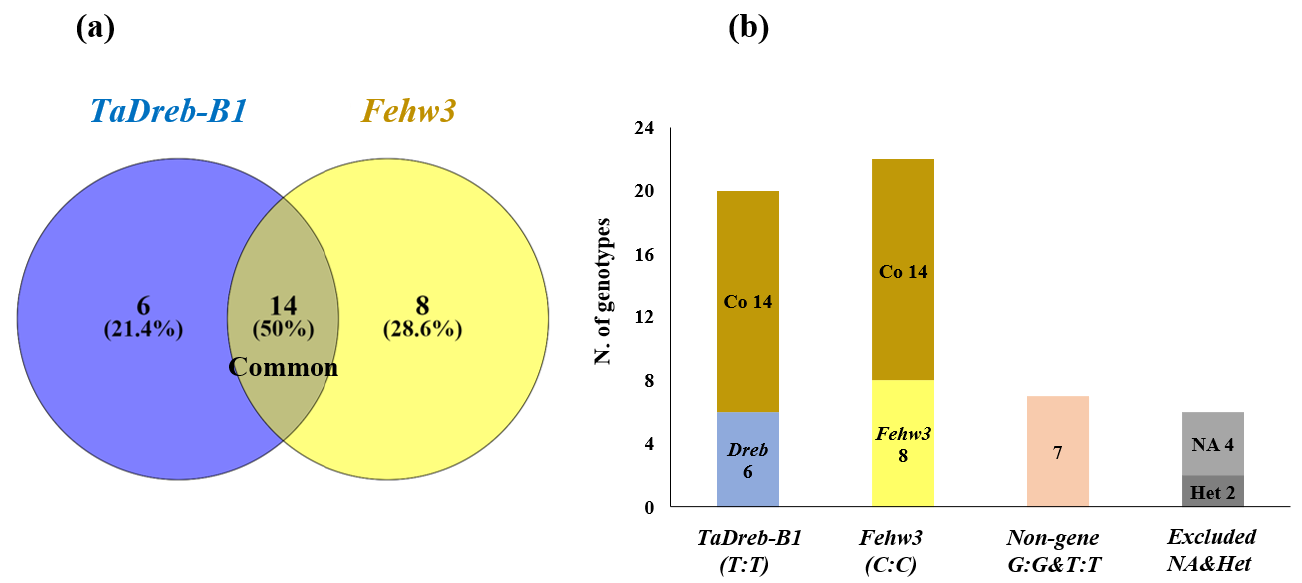
Figure 4. ( a , b ). Venn diagram for the common genotypes that contain both types of specific drought genes ( TaDreb-B1 , Fehw3 ), where Co refers to common genotypes that contain the two target genes ( TaDreb-B1 , Fehw3 ), excluded genotypes included both heterozygous loci ( Het ) and missing genotypes (NA).